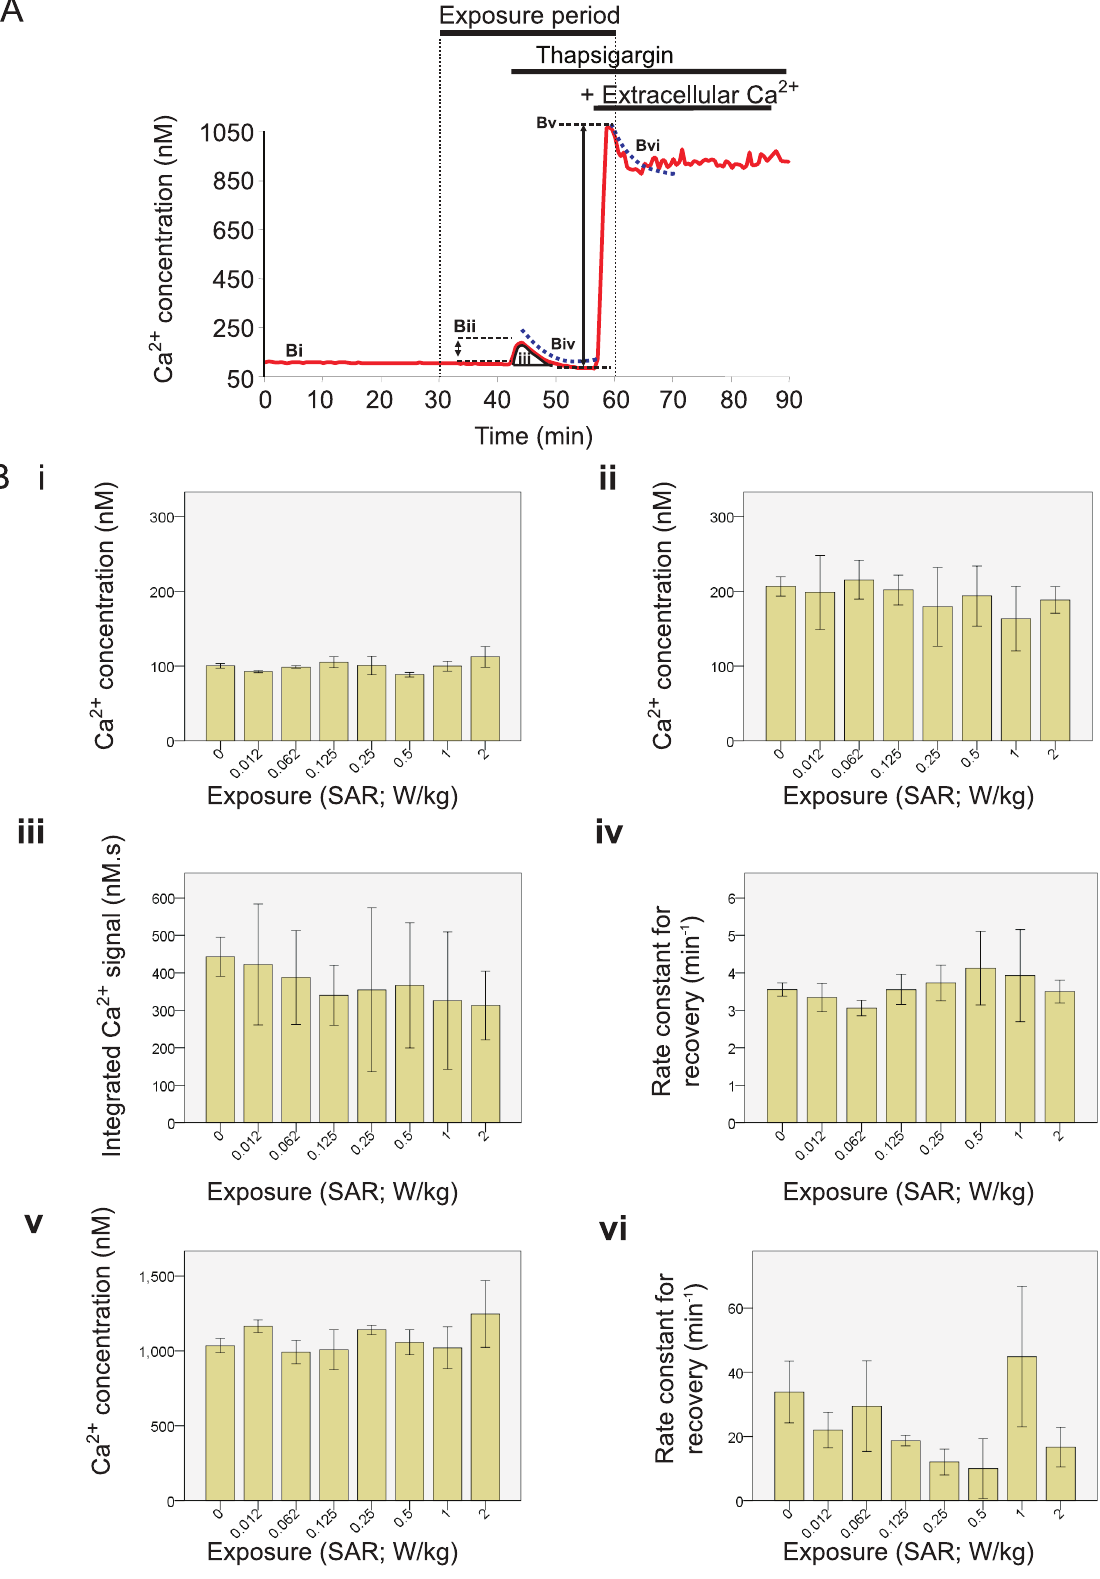
Figure 6. Effect of RF exposure on thapsigargin-induced Ca 2 + Signals. Cytosolic Ca 2 + was manipulated in EA.hy926 cells through the application of thapsigargin during the exposure period. Cells were exposed to 900 MHz RF fields at 7 levels of SAR with GSM modulated power. A ; illustration of the protocol used for thapsigargin experiments, showing the various Ca 2 + signals elicited by thapsigargin and addition of extracellular